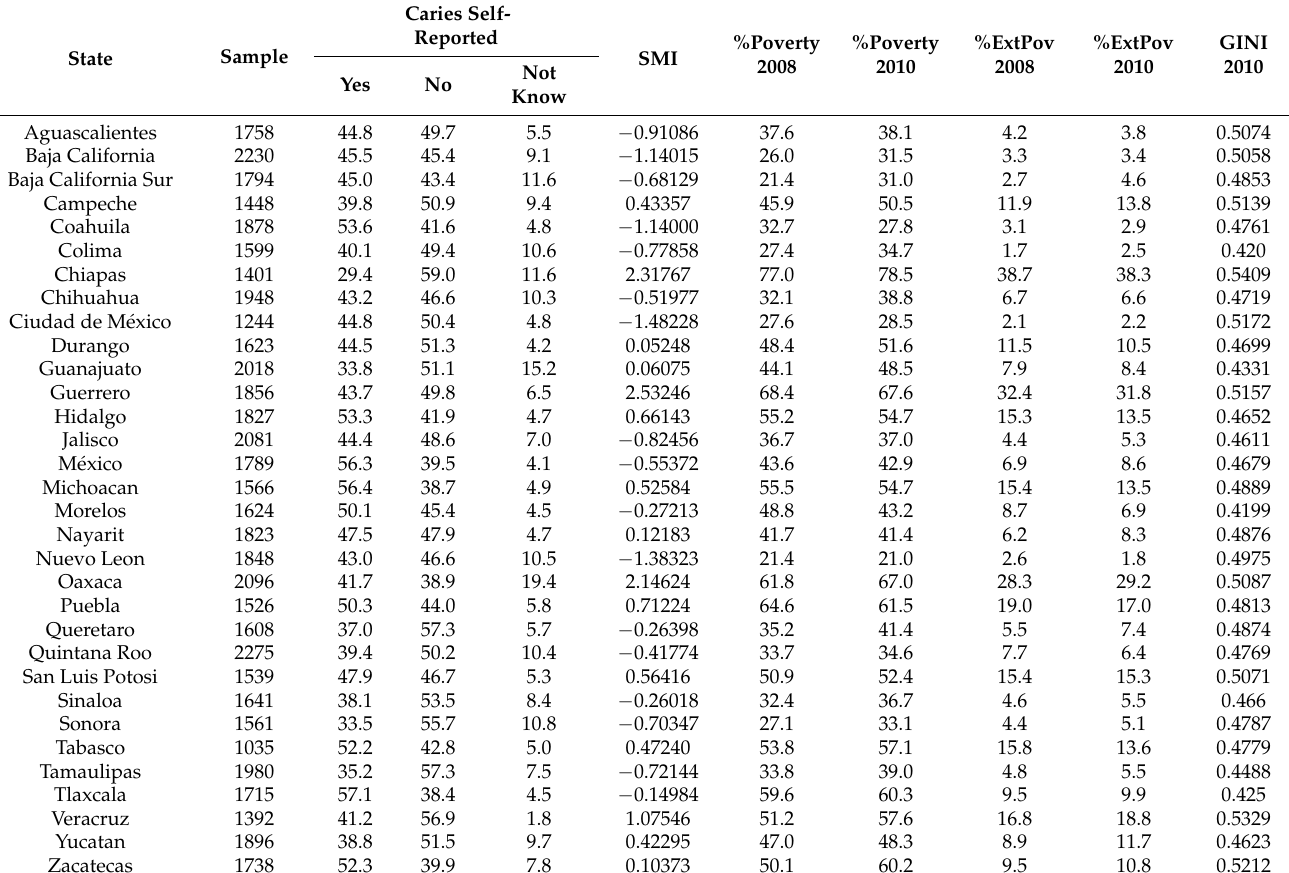
Table 3. State prevalence of caries self-report in elementary and middle schoolchildren in